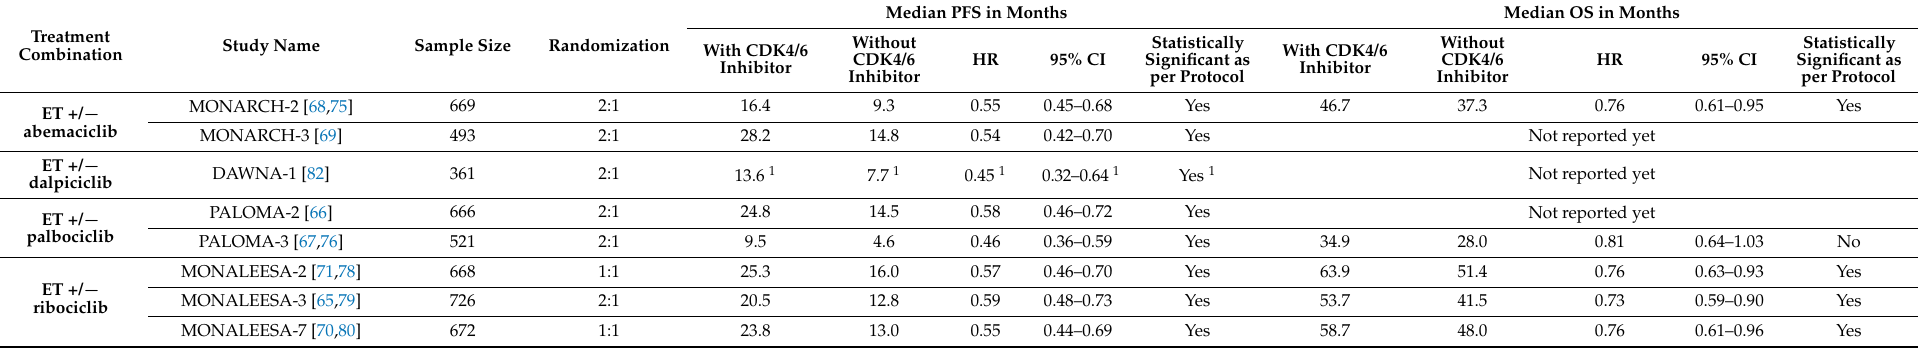
Table 1. Efficacy of CDK4/6 inhibitors in hormone-receptor-positive, HER2-negative aBC phase III trials (in alphabetical and numerical order). Treatment